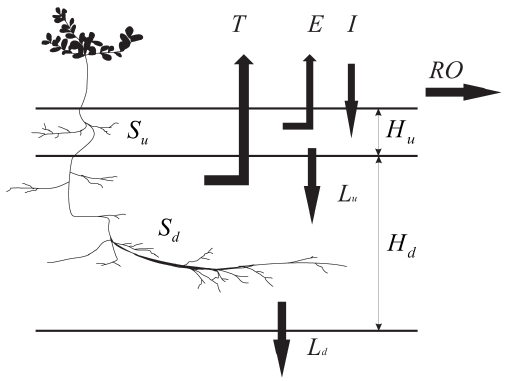
Fig. 3. Scheme of the conceptual